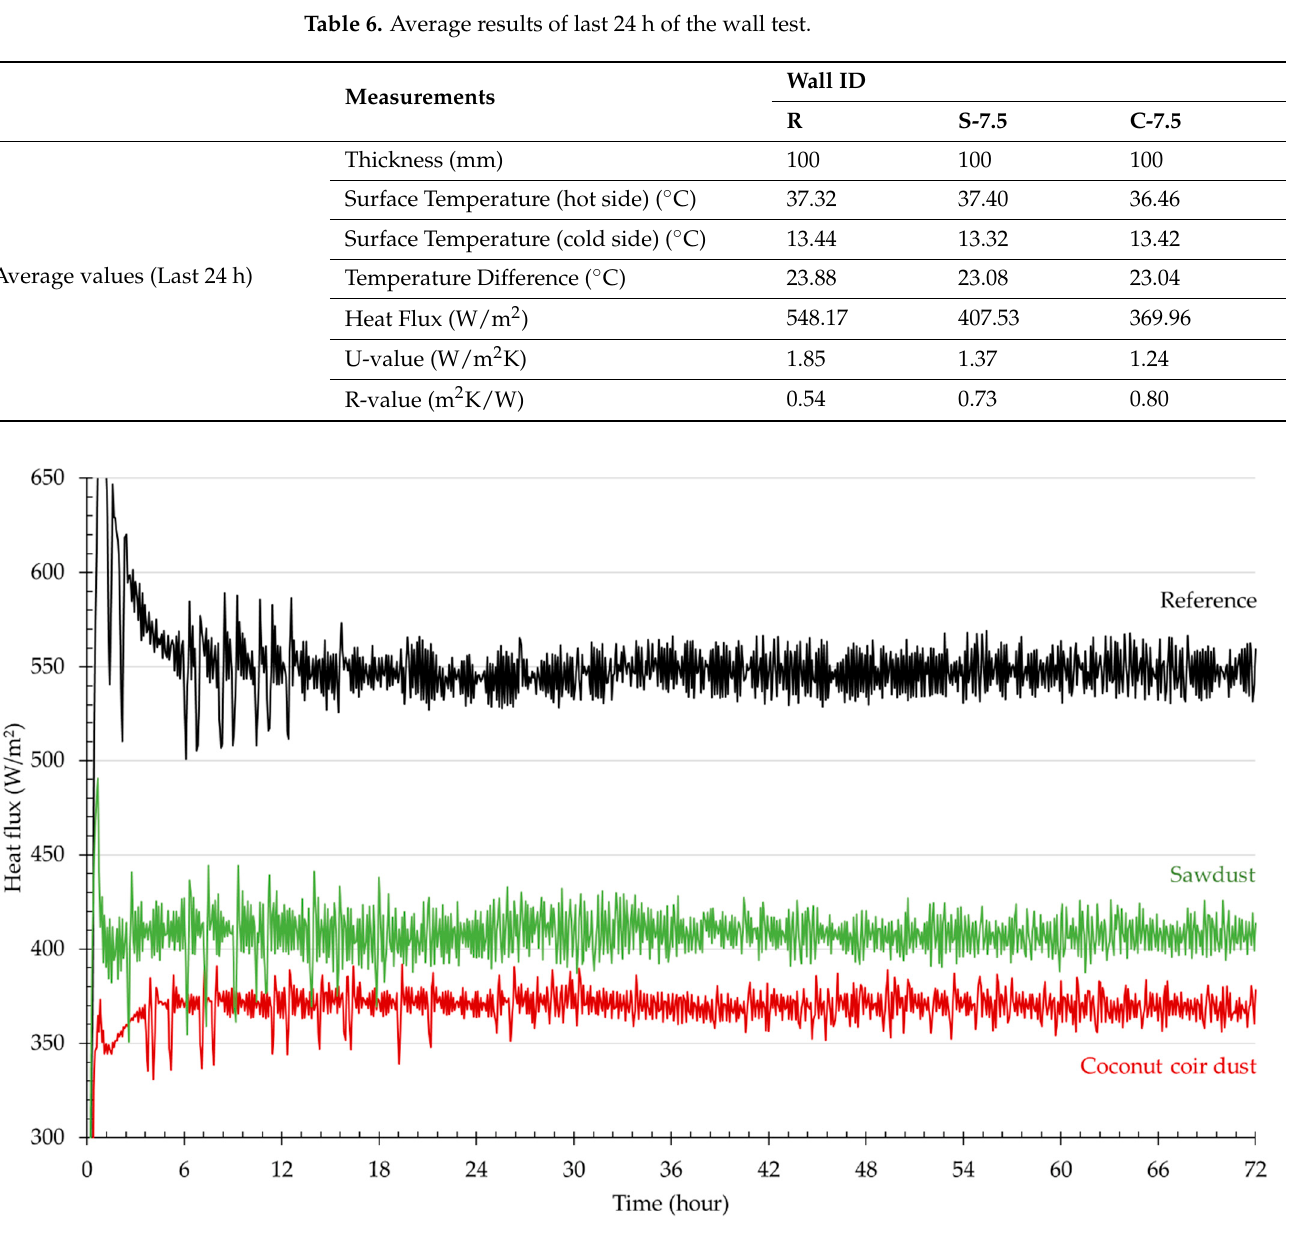
Figure 12. Heat fluxes across the walls (72